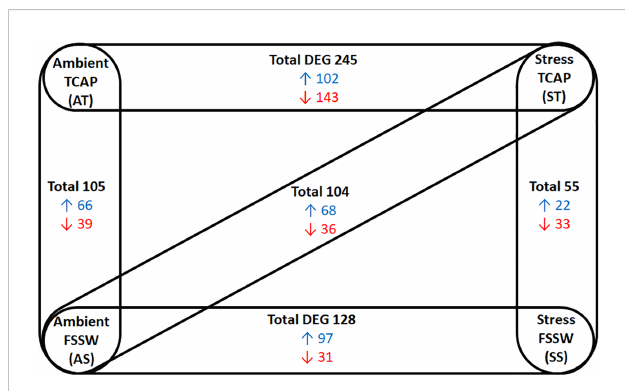
FIGURE 2 Changes in gene expression in SRO heart in response to sroTCAP or FSSW exposed to either ambient or stress conditions, showing fi ve different pair-wise comparisons. Experimental groups showed signi fi cant DEG (at FDR ≤ 0.05 with log fold change ≥ 1 and ≤ -1) in each pair-wise comparison. Blue: upregulated DEG, red: Down- regulated DEG.